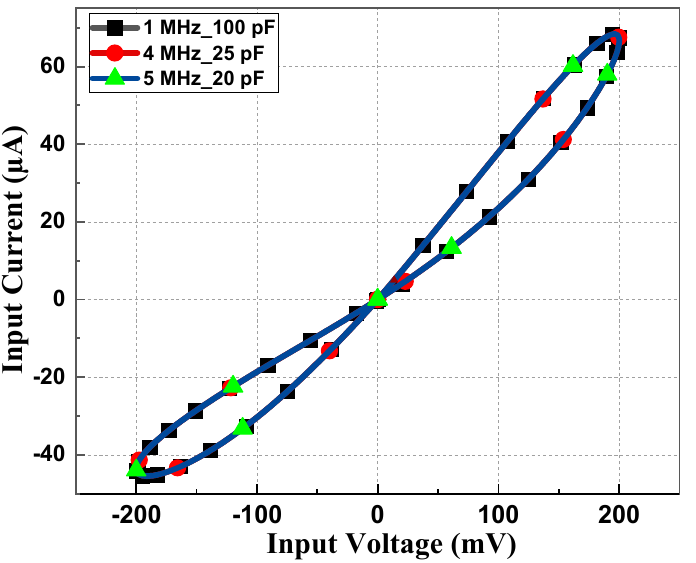
Figure 8. PHL at constant fC product.